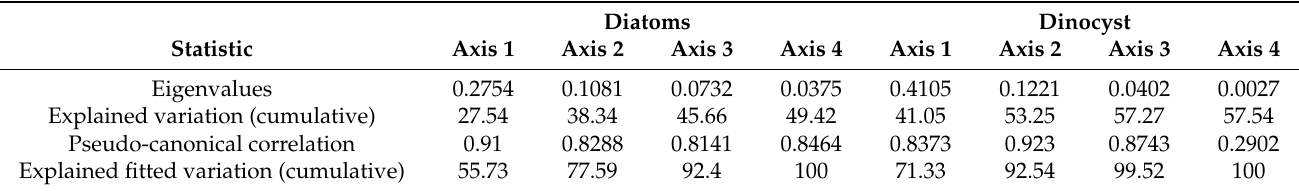
Table 1. Results of redundancy analysis.